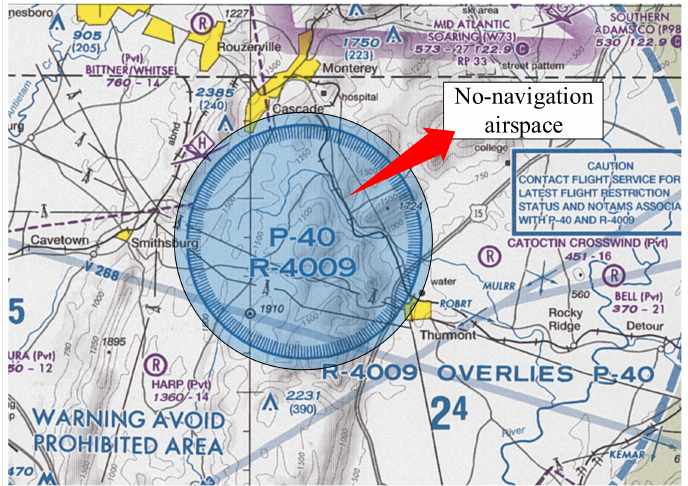
Figure 1. Example of no-navigation airspace (no-navigation airspace of P-40 R-4009 around Camp